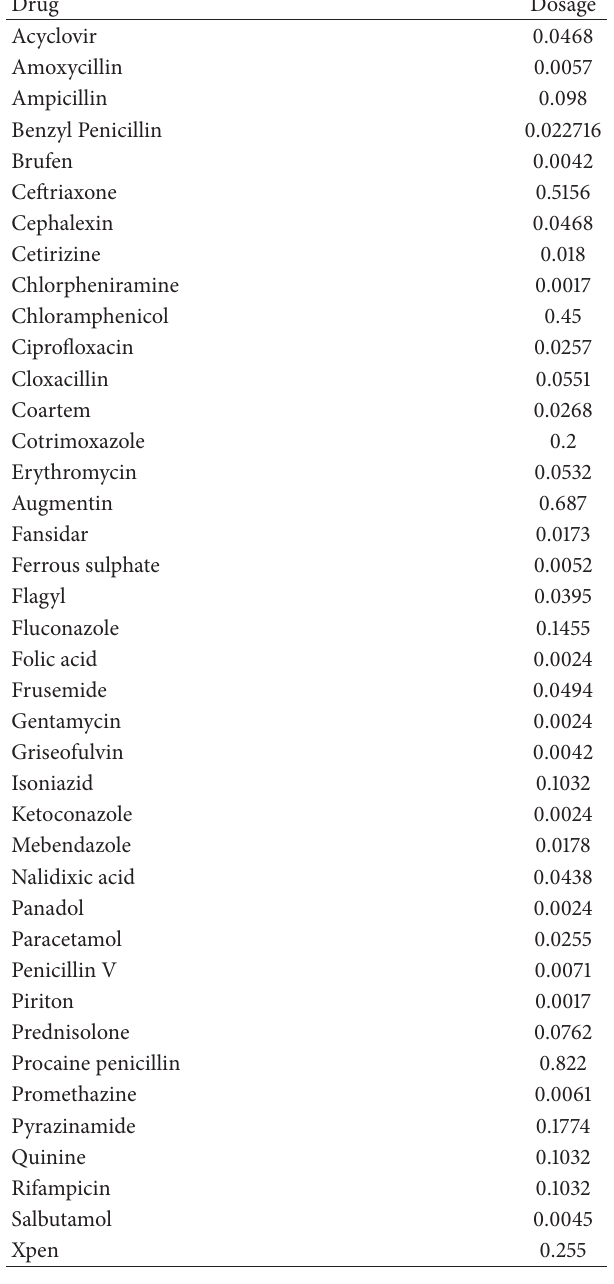
Table7:UnitPricesofcotrimoxazoleprophylaxisandopportunistic infection medication